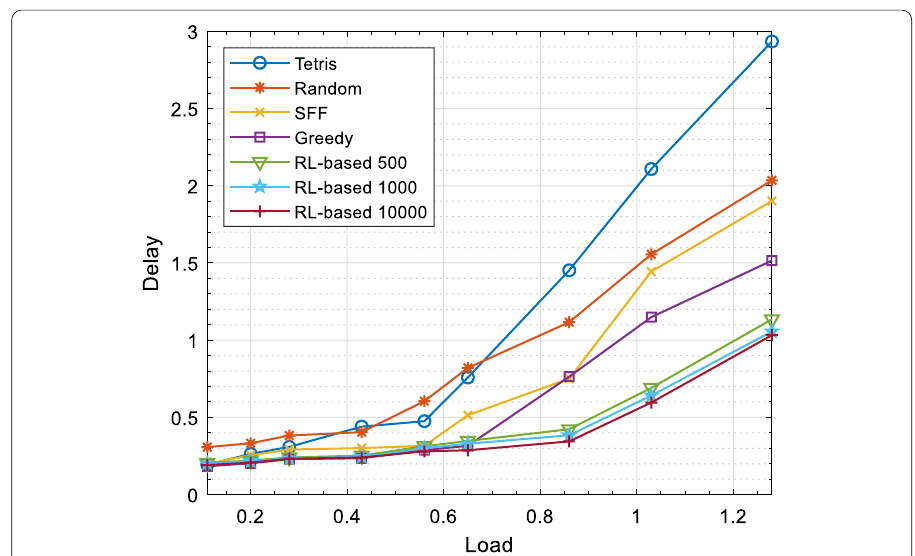
Fig. 8 Delay performance comparison of different schemes. The delay comparison of the RL-based, Greedy, Random, SFF, and Tetris schemes at varying loads is shown in figure. Among them, the RL-based scheme selected 500 times, 1000 times, and 10,000 times training data, respectively. The x -axis is the loads, and the y -axis is the average delay. We record the delay performance of each scheme with 9 sampling points from load 0.11 to